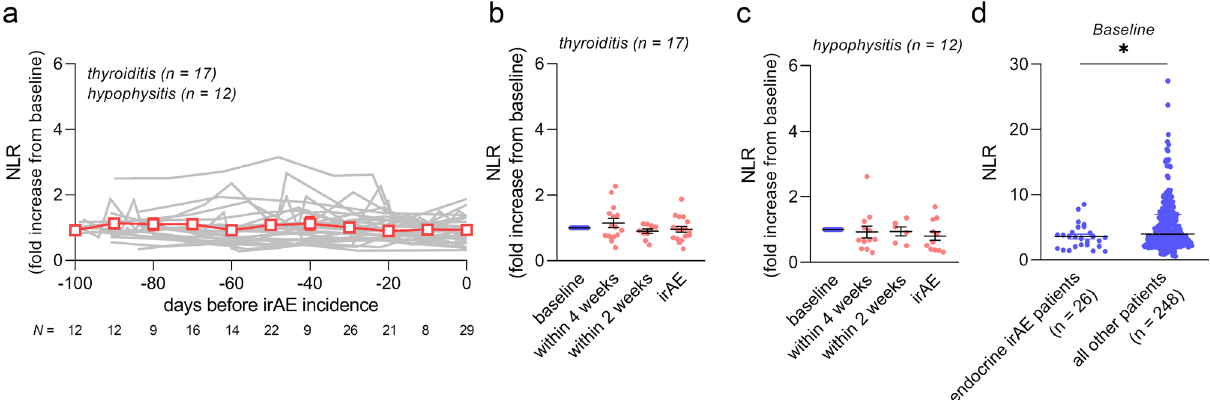
Figure 3. NLR trends in patients with endocrine irAEs. ( a ) Plotting the NLR trends during the 100 d before the development of ICI-related thyroiditis (n = 17) and hypophysitis (n = 12). The gray line indicates the individual patients, and the red line shows the mean ± SEM. ( b ) NLR elevation from the baseline was analyzed at each time point in thyroiditis, and ( c ) hypophysitis. ( d ) Pre-treatment NLR (baseline) was compared among patients who experienced endocrine irAEs (n = 26) and all other patients in our dataset (n = 248). Statistical analysis included one-way ANOVA with a mixed-effects model followed by Holm–Sidak’s post hoc test ( b ), one-way ANOVA with Tukey’s post hoc test ( c ), and Mann–Whitney test ( d ). Data are shown as the mean ± SEM ( b, c ), and the median in ( d ), * p < 0.05. NLR neutrophil-to-lymphocyte ratio, ICI immune checkpoint inhibitor, irAE immune- related adverse event.